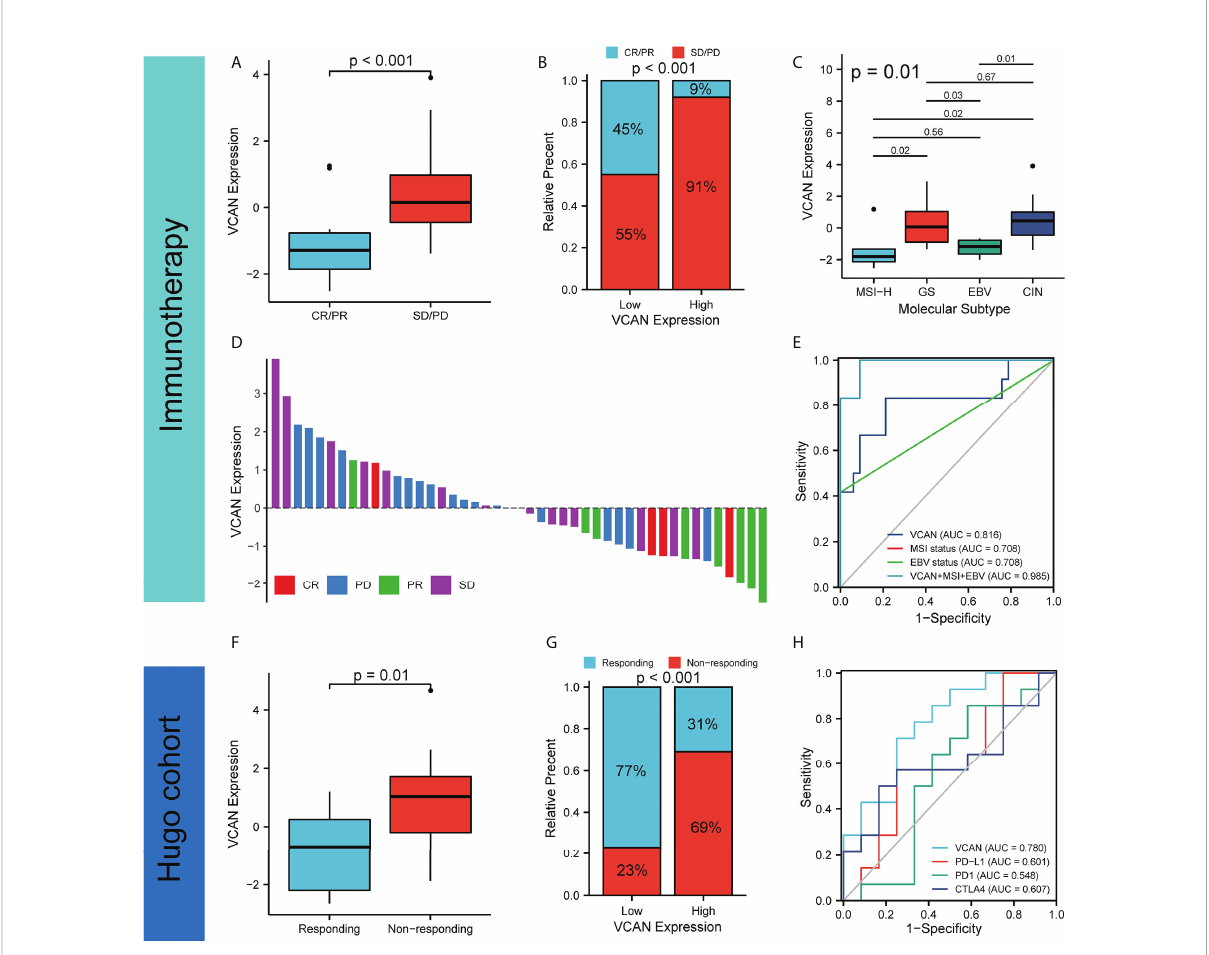
FIGURE 3 VCAN expression predicted response to immunotherapy. (A) The expression of VCAN in complete response (CR)/partial response (PR) group and stable disease (SD)/progressive disease (PD) group in KIM cohort. (B) Proportion of CR/PR and SD/PD in low VCAN group and high VCAN group in KIM cohort. (C) The expression of VCAN in patients with different molecular subtypes in KIM cohort. (D) The expression of in patients with different immunotherapy responses in KIM cohort. (E) Receiver operating characteristic (ROC) curves of VCAN expression, MSI status, and EBV status in predicting immunotherapy response in KIM cohort. (F) The expression of VCAN in responding group and non-responding group in Hugo cohort. (G) Proportion of responding and non-responding to immunotherapy in low VCAN group and high VCAN group in Hugo cohort. (H) ROC curves of VCAN, PD-L1, PD1 and CTLA4 expression in predicting immunotherapy response in Hugo